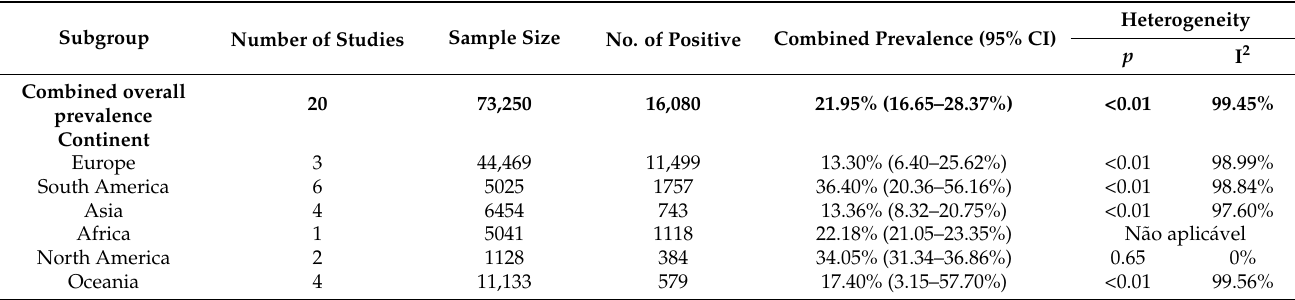
Table 2. Summary of the meta-analysis of the seropositivity of swine leptospirosis according to continent and sample size.